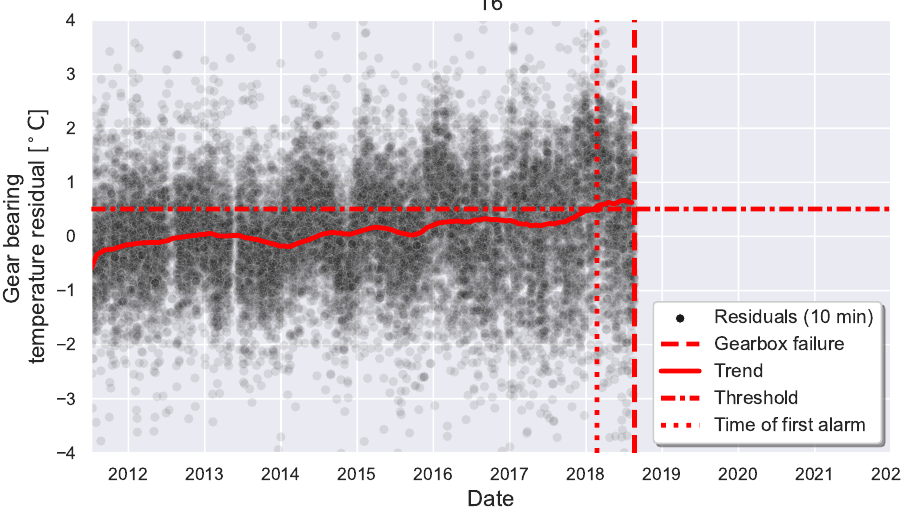
Figure 7. Upward trend of the residuals over the threshold. The horizontal dash-dotted line represents the threshold. The vertical dotted and dashed lines represent the time when trend goes above the threshold (alarm raised) and when the failure is reported,